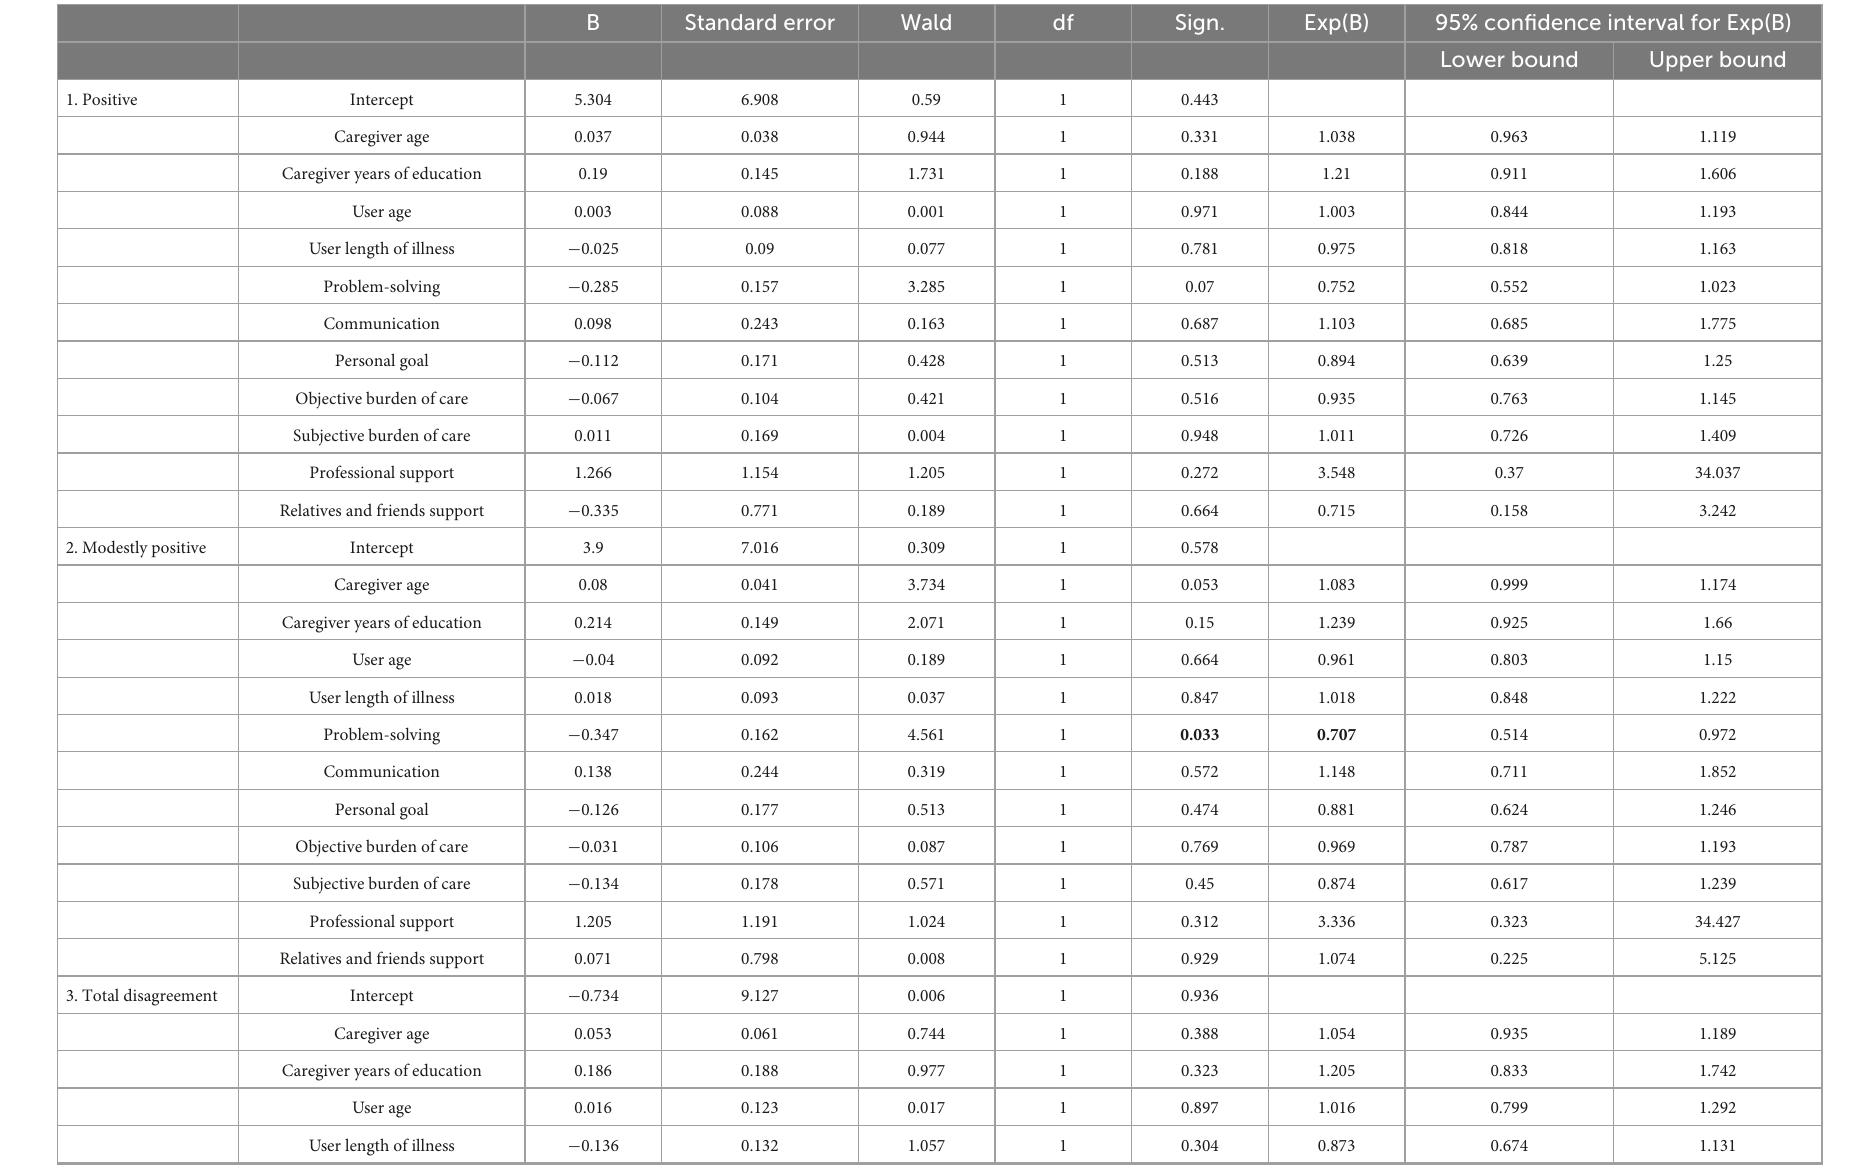
TABLE 6 Logistic multinominal regression for a = item 31 [“ All things considered, I learned something positive from this situation (for example, to understand myself and others better ,” score 1 D very much)] of the questionnaire for family problems, as dependent